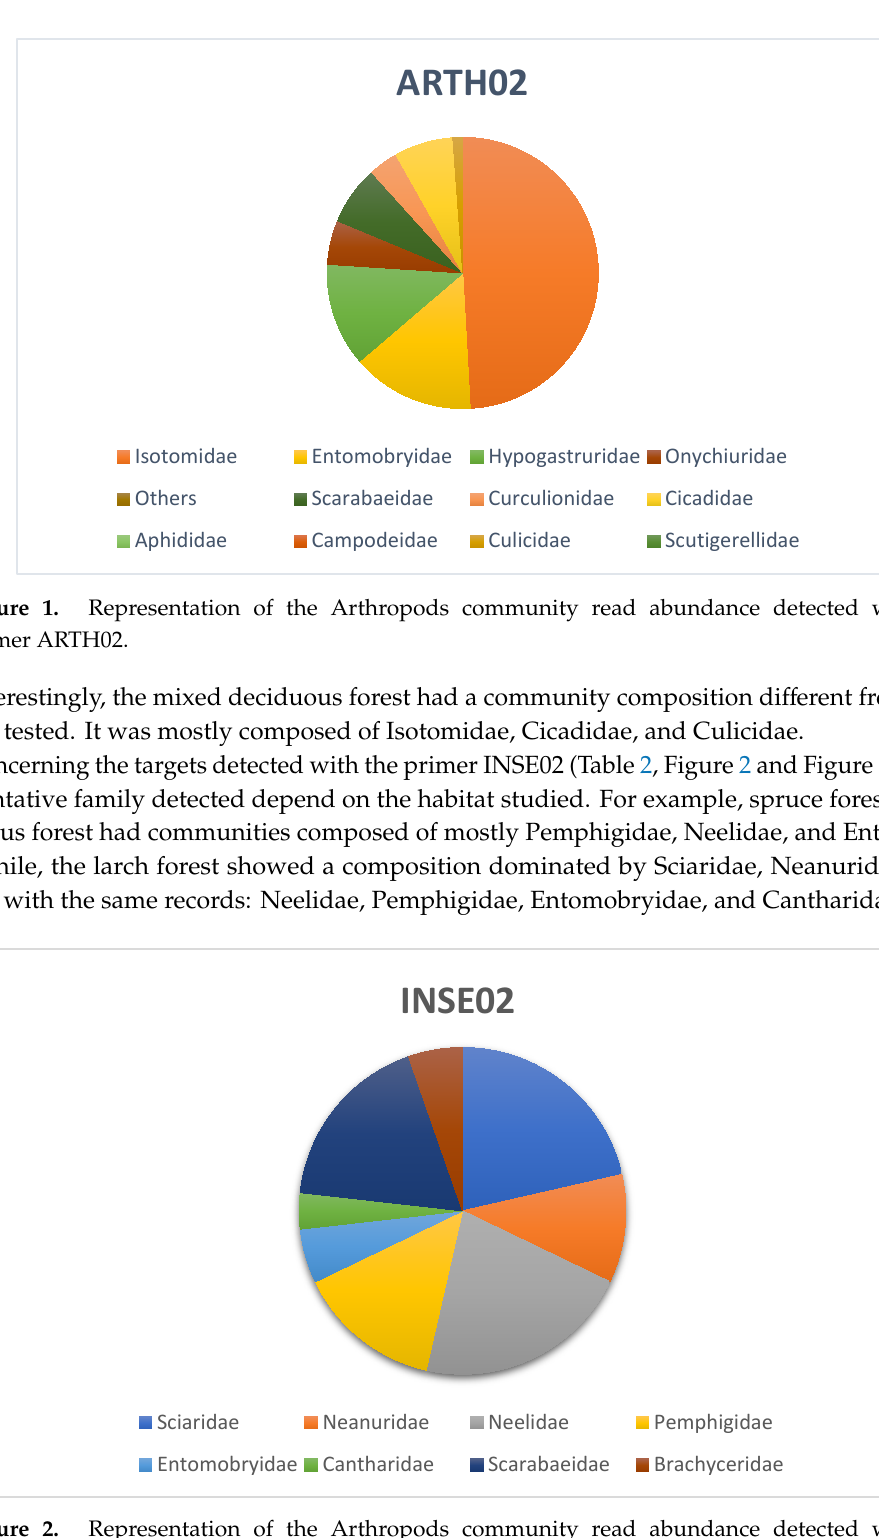
Figure 2. Representation of the Arthropods community read abundance detected with the primer INSE02.